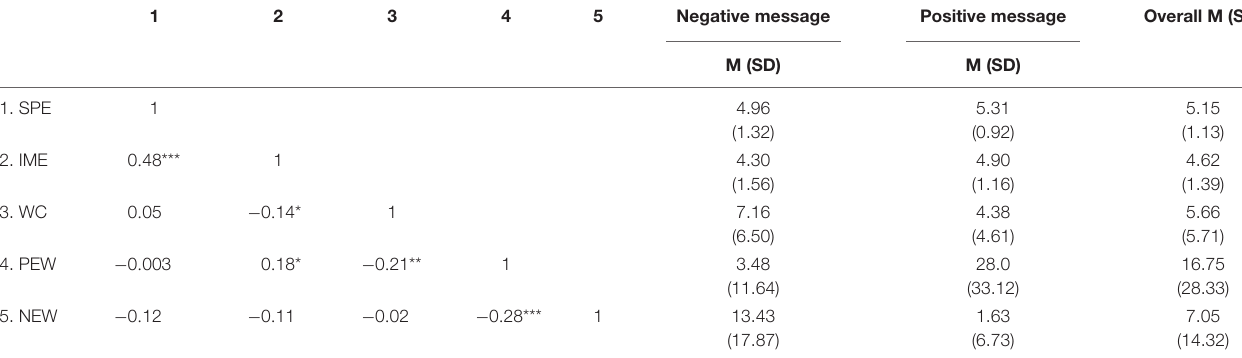
TABLE 1 | Correlations and means and standard deviations of dependent variables by message